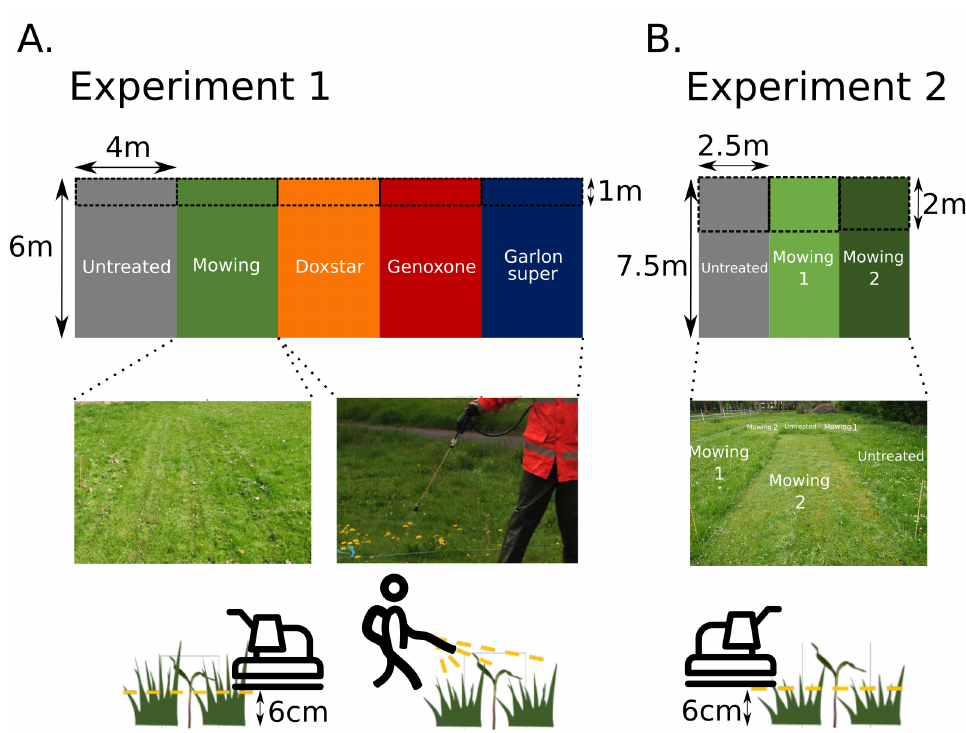
Figure 1. Illustration of a block in experiments 1 and 2. ( A ) Experiment 1—pasture 1: each block was subdivided in five lanes illustrated in grey (untreated area), in green (mowed area), in orange (Doxstar ® ), in red (Genoxone ® ) and in blue (Garlon Super ® ). Each lane measured 6 m height and 4 m width and within each lane, a zone was dedicated to counting of seedlings represented by a dotted zone; ( B ) Experiment 2—pasture 2: each block was subdivided in three lanes illustrated in grey (untreated, i.e., no mowing), in light green (mowing performed on 5 April 2019) and in dark green (mowing performed on 29 April 2019). Each lane measured 7.5 m height and 2.5 m width and within each lane, a zone was dedicated to counting of seedlings represented by a dotted zone. Pictures in real condition are displayed. In both experiments, the cutting height of the mowing machine was 6